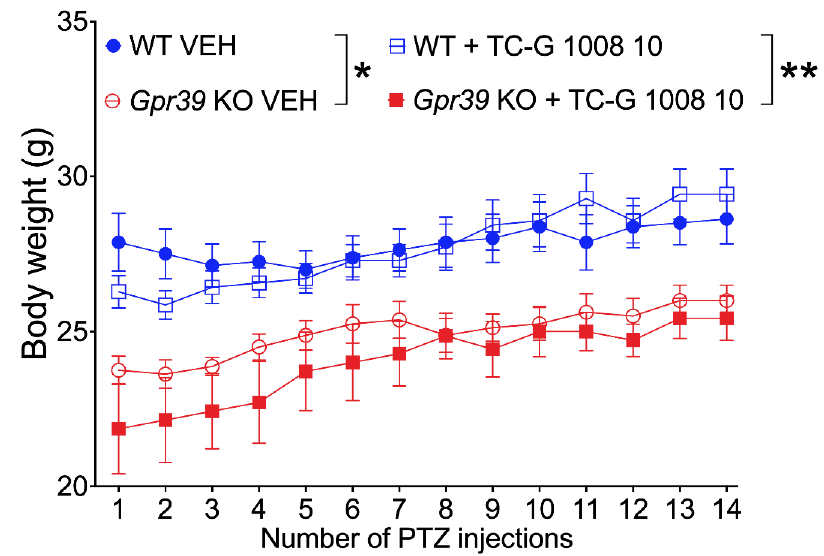
Figure 3. The effects of chronic treatment with TC-G 1008 (10 mg/kg) on the body weight of Gpr39 -KO or WT (C57BL/6/Tar × CBA/Tar) mice subjected to the PTZ kindling model. The mice were injected i.p. with TC-G 1008 or VEH (1% Tween 80 in physiological saline) on every alternate day during weekdays; 30 min later, PTZ (25 mg/kg) was injected i.p. The model consisted of 14 injections of PTZ. Data were analyzed by three-way ANOVA and Bonferroni’s multiple comparison test. Statistical details: genotype [F(1,26) = 22.743, p < 0.0001]; drug [F(1,26) = 0.682, p = 0.416334]; genotype × drug [F(1,26) = 0.335, p = 0.567442]; time [F(13,338) = 32.006, p < 0.0001]; time × genotype [F(13,338) = 4.671, p = 0.0353]; time × drug [F(13,338) = 1.847, p < 0.0001] (by three-way repeated measures ANOVA); n = 8 WT VEH, n = 7 WT TC-G 1008, n = 8 KO VEH, n = 7 KO TC-G 1008. * p < 0.05, ** p < 0.01 (by Bonferroni’s multiple comparison test).